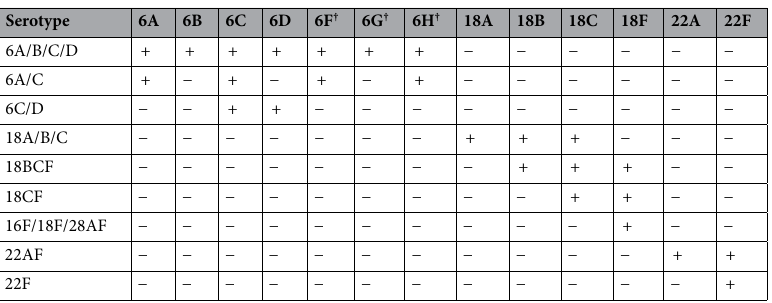
Table 4. Algorithm to discriminate serogroups 6, 18 and 22 to individual serotypes using the described reaction sets. † Theoretical detection pattern predicted in silico, no bacterial isolates or clinical isolates were available to